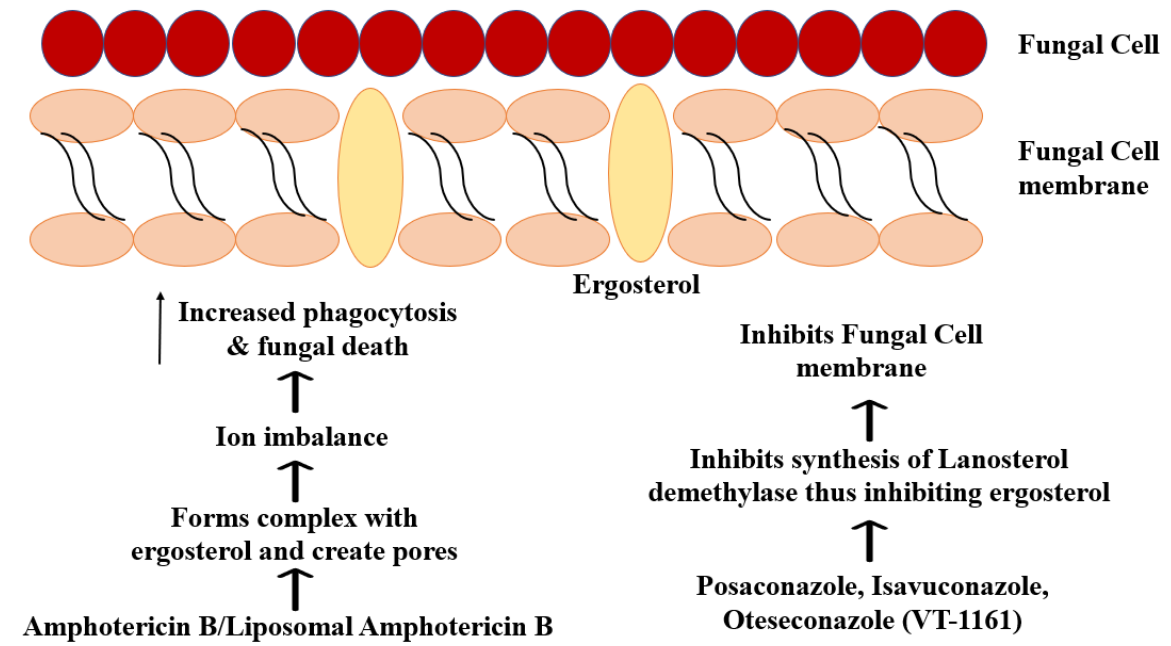
Figure 1. Drug action of Amphotericin B and azoles in the fungal cell membrane.